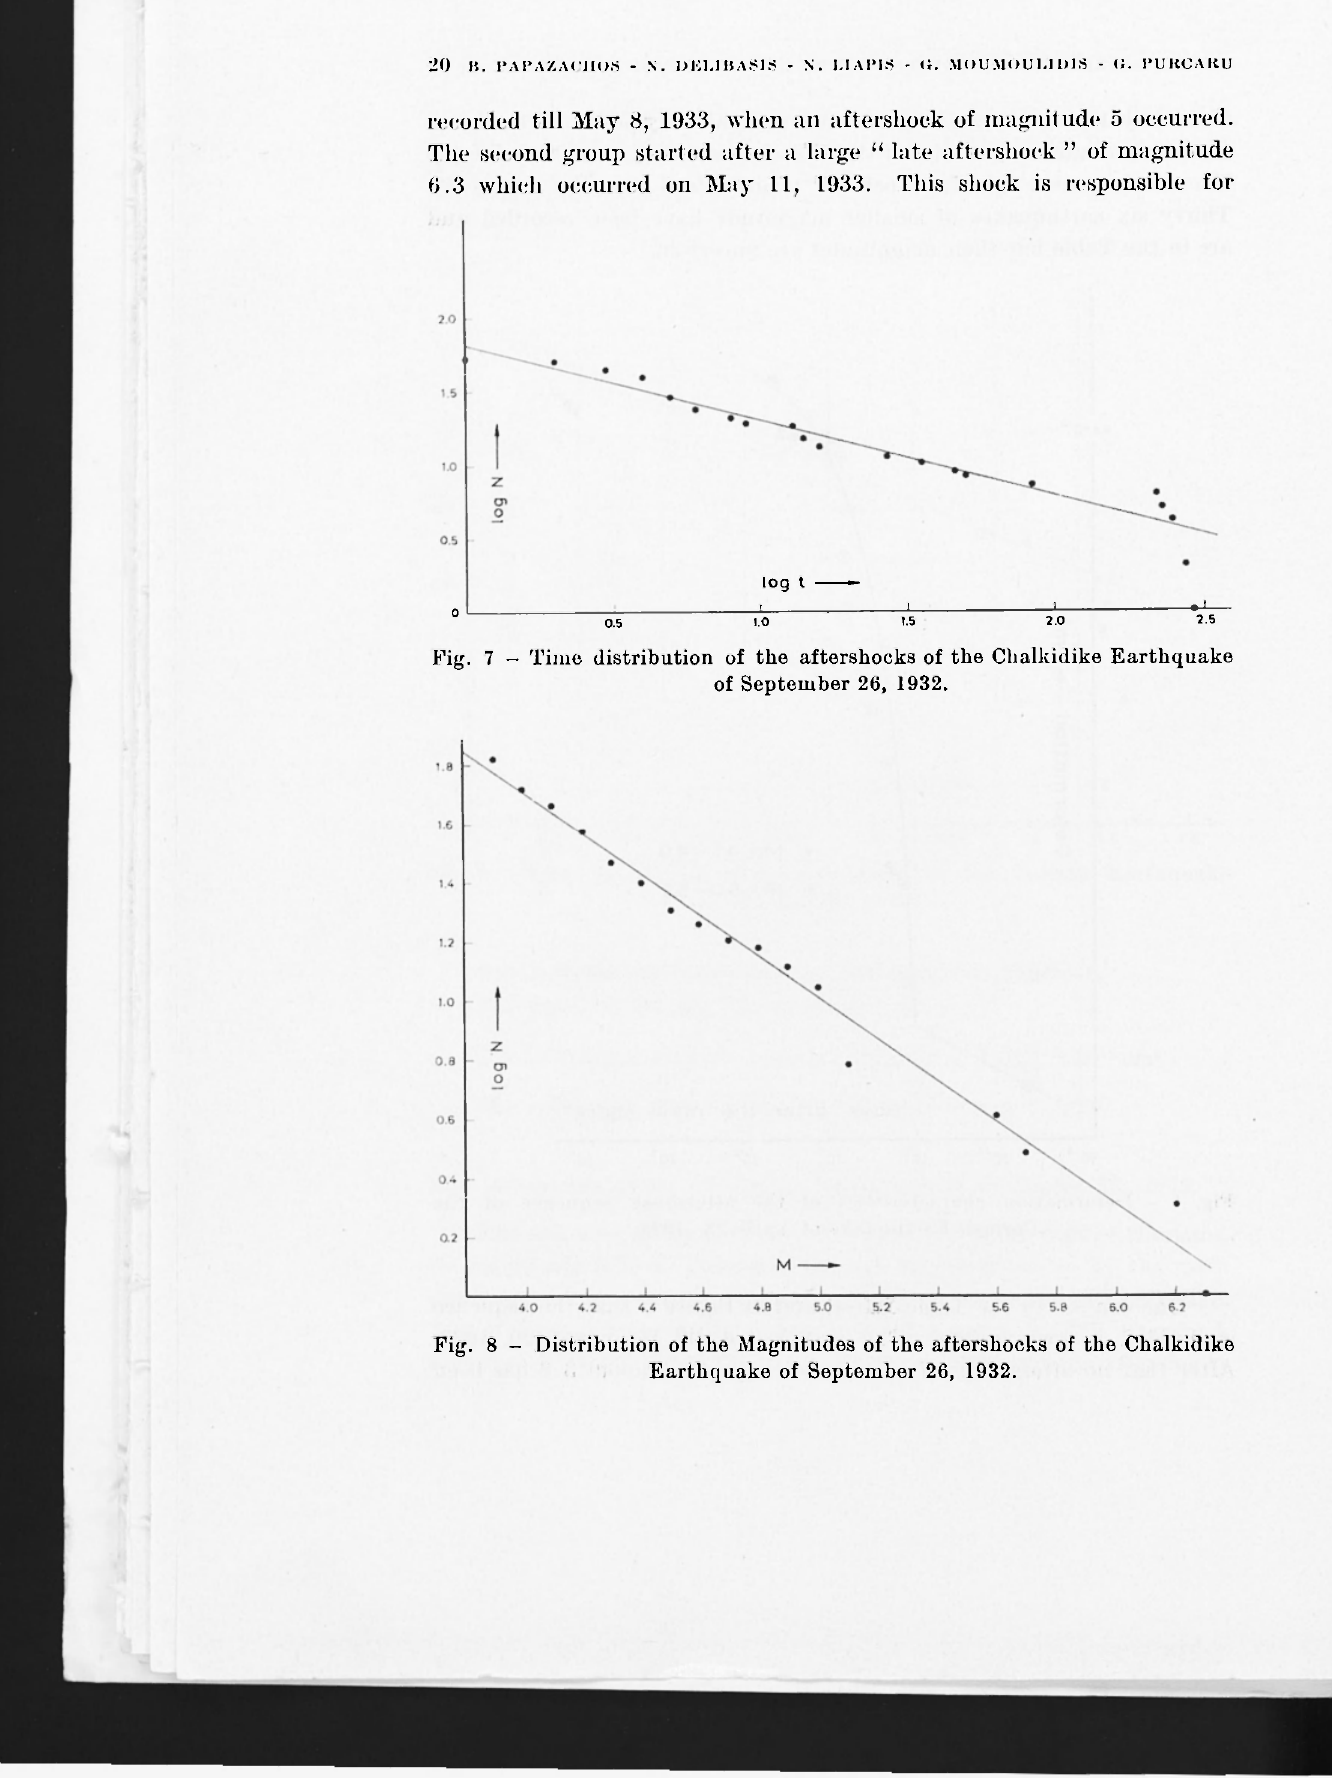
Fig. 8 - Distribution of the Magnitudes of the aftershocks of the Chalkidike Earthquake of September 26,